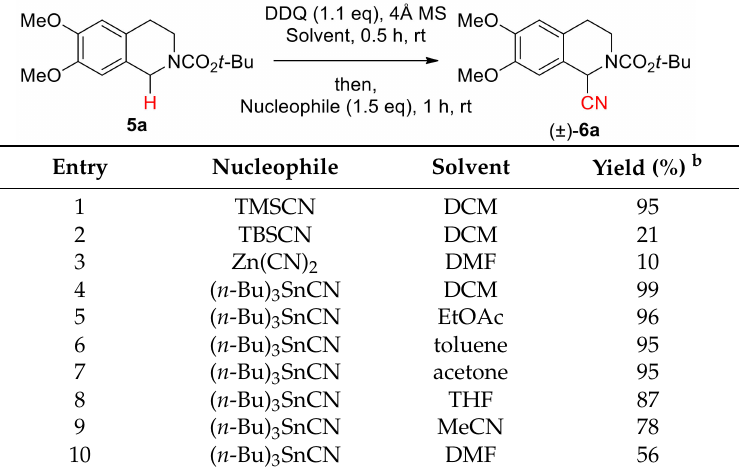
Table 1. Optimization of DDQ-promoted α -cyanation of N -Boc THIQ 5a a